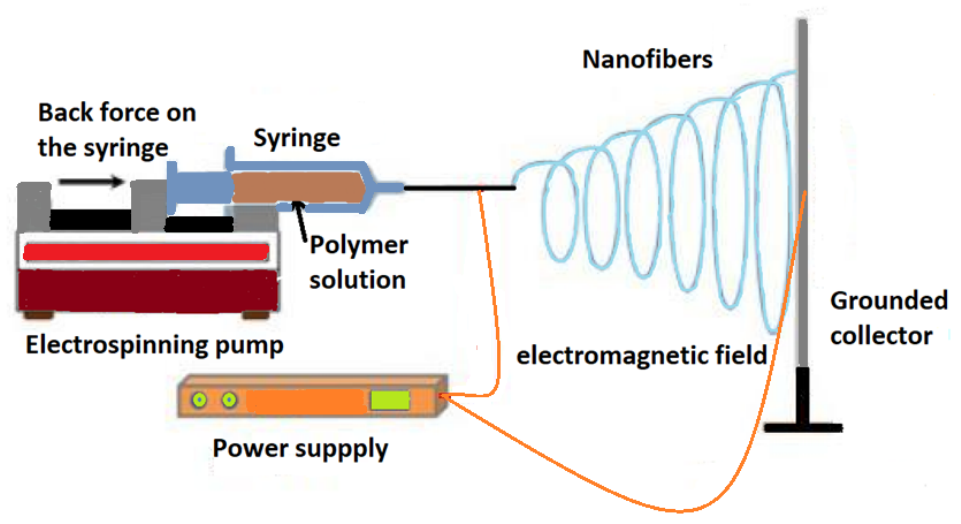
Figure 2. General electrospinning setup. Reprinted from ref.